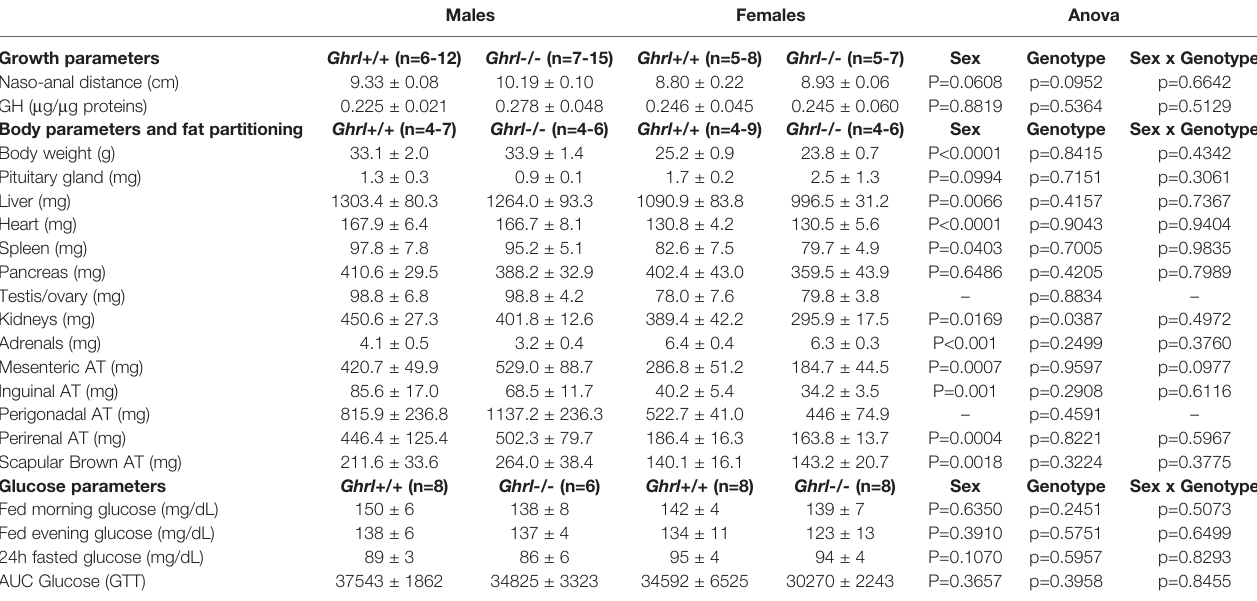
Growth parameters, mass of organs (pituitary gland, liver, heart, spleen, pancreas, testis/ovary, kidney, adrenals), fat mass deposits (mesenteric, inguinal, perigonadal, perirenal and scapular brown adipose tissue), blood glucose parameters (Fed 10.00, Fed 18.00, 24h Fasted and AUC during glucose tolerance) were measured in adult Ghrl+/+ and Ghrl-/- male and female mice. Numbers of mice are indicated in parenthesis. Data represent mean± SEM. AT, Adipose Tissue; AUC, Area Under the Curve; GTT, Glucose Tolerance